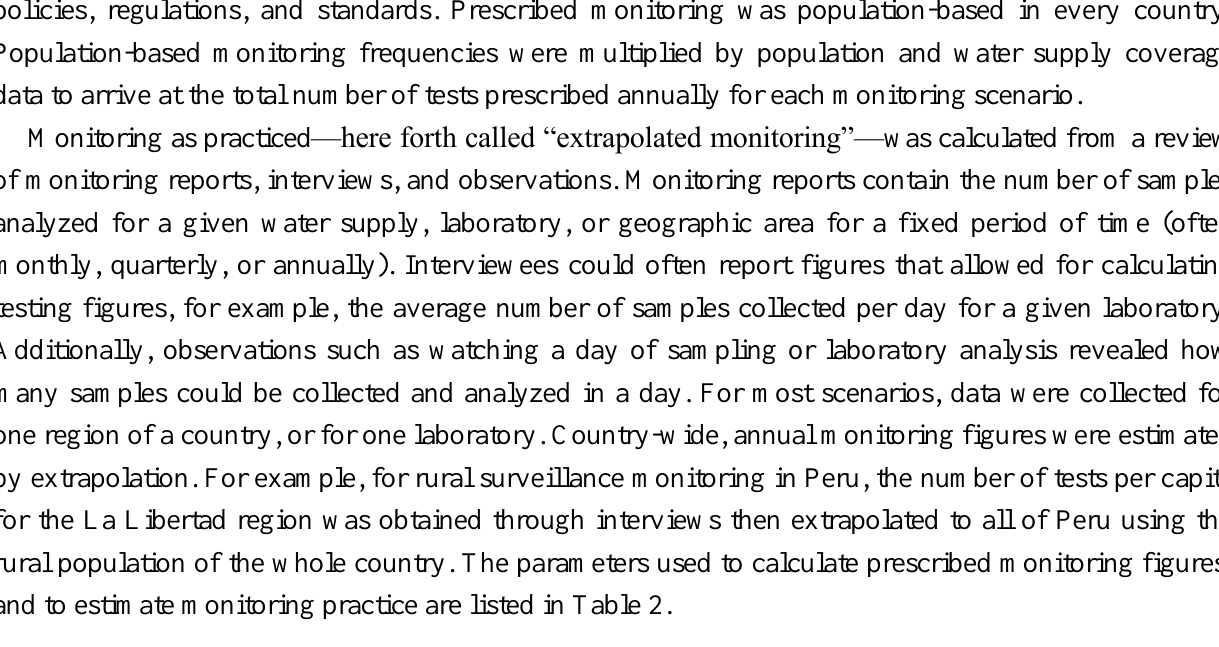
Table 2. Parameters used to calculate monitoring as prescribed and estimate monitoring as